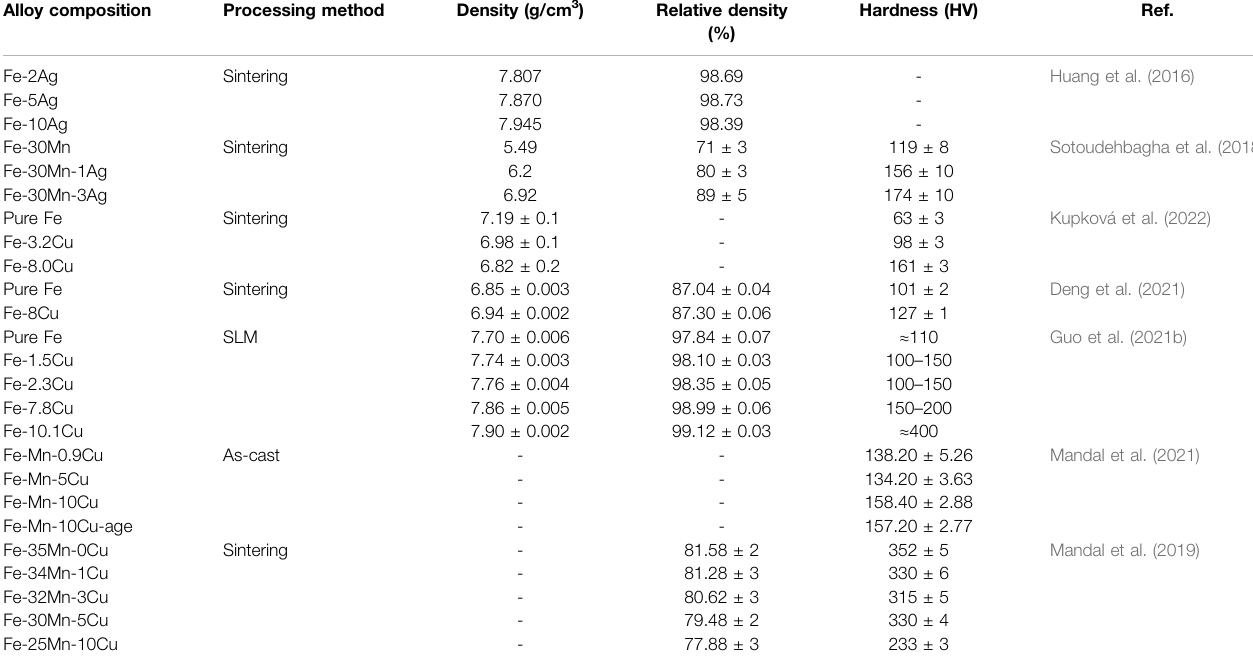
TABLE 7 | Mechanical properties of Fe-based alloys with antibacterial properties as orthopedic implants. Alloy